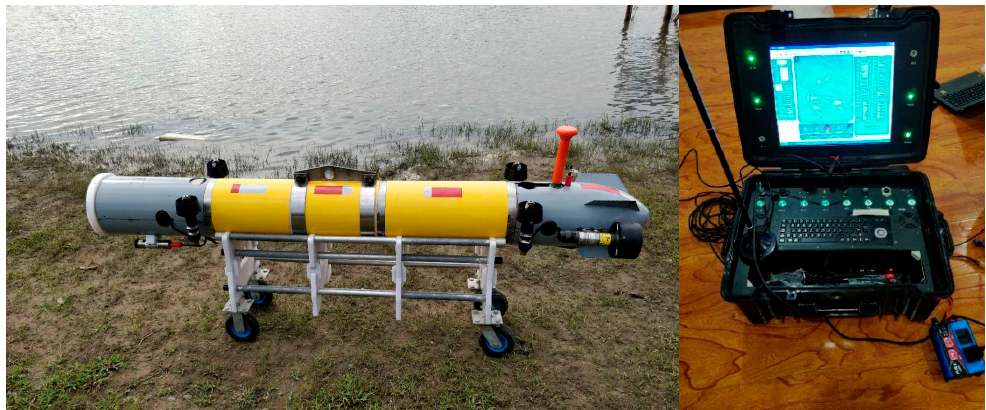
Figure 2. Plateau data-gathering AUV system (left: developed AUV; right: ground station).